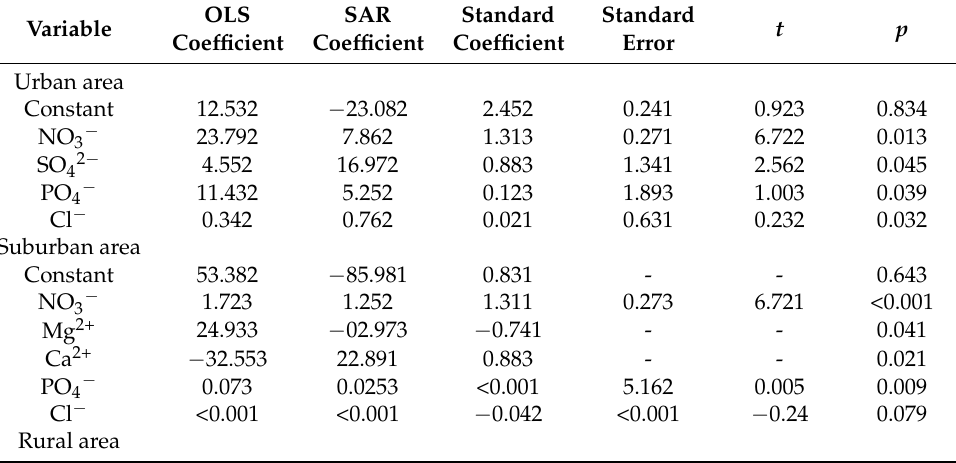
Table 3. Results for spatial autoregressive models. A level of the studied element in rainwater was chosen as a dependent variable, while levels of elements in the surface watercourse were used as independent variables. Only significant results were